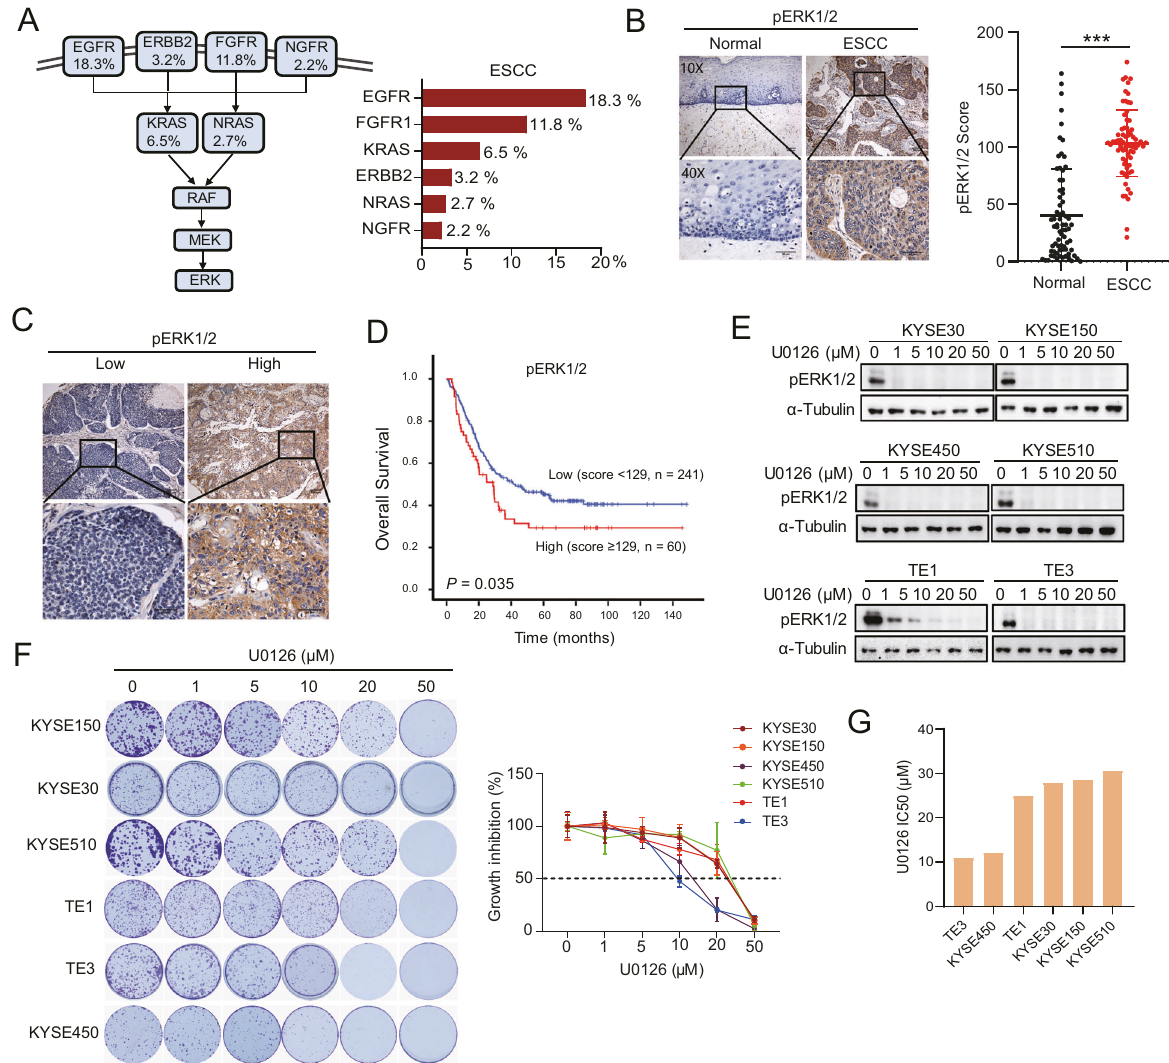
Fig. 1 Hyperactive phospho-ERK (pERK) in patients with ESCC is associated with poor prognosis. A Frequencies of upstream mitogen- activated protein kinase kinase (MEK)/extracellular signal-regulated kinase (ERK) signaling-related gene ampli fi cation ( EGFR, ERBB2, FGFR, NGFR, KRAS , and NRAS ) in ESCC from The Cancer Genome Atlas. B pERK immunohistochemistry (IHC) in tumor and para-carcinoma tissues of patients with ESCC. Representative images of pERK expression in normal and ESCC tissues ( n = 72) and statistical results. Scale bar, 100 μ m. Data are presented as the mean ± standard deviation (SD). *** P < 0.001. C Representative low and high expression of pERK in tumor tissues obtained using IHC. D Kaplan – Meier survival curve of overall survival based on the expression of pERK ( n = 301) in patients with ESCC. E Western blotting shows pERK expression after different concentrations of U0126 treatment in six ESCC cell lines. F Colony formation assays for six ESCC cell lines after different concentrations of U0126 treatment for 7 – 10 days. The growth inhibition ratio was calculated according to the number of colonies formed. G U0126 drug sensitivity IC50 values in six ESCC cell